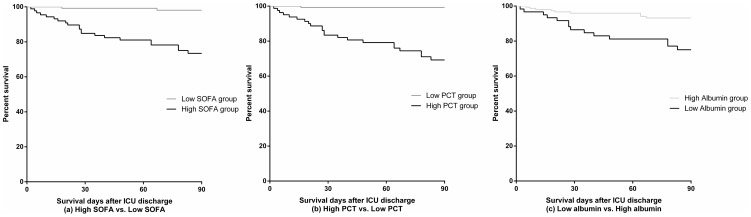
Kaplan-Meier survival curve for 90 days after ICU discharge in high and low groups divided by SOFA, PCT, and albumin.(a) High SOFA vs. Low SOFA group. (b) High PCT vs. Low PCT group. (c) Low albumin vs. High albumin group. The graph shows curves for the two groups (high SOFA vs. low SOFA, high PCT vs. low PCT, and low albumin vs. high albumin) derived from the cutoff value for SOFA score at 6 (P<0.001), PCT level at 0.57 ng/mL (P<0.001), and albumin level at 2.5 g/dL (P = 0.001) at ICU discharge (log-rank test). ICU, intensive care unit; PCT, procalcitonin; SOFA, Sequential Organ Failure Assessment.